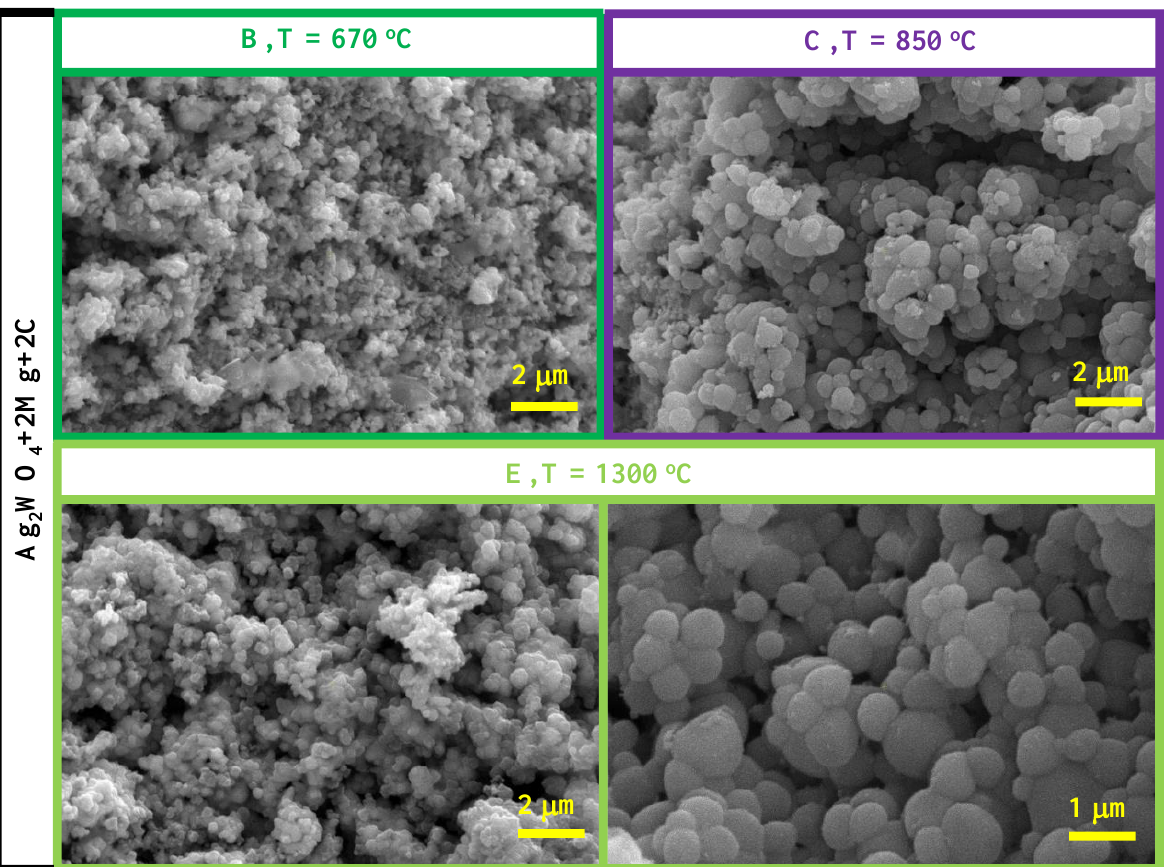
Figure 9. SEM images of quenched samples for the Ag 2 WO 4 + 2Mg + 2C mixture. As can be seen from Figure 10a, the exothermic interactions shifted to a higher temper- ature range when switching to a higher heating rate (from 100 to 1200 ◦ C min − 1 ).